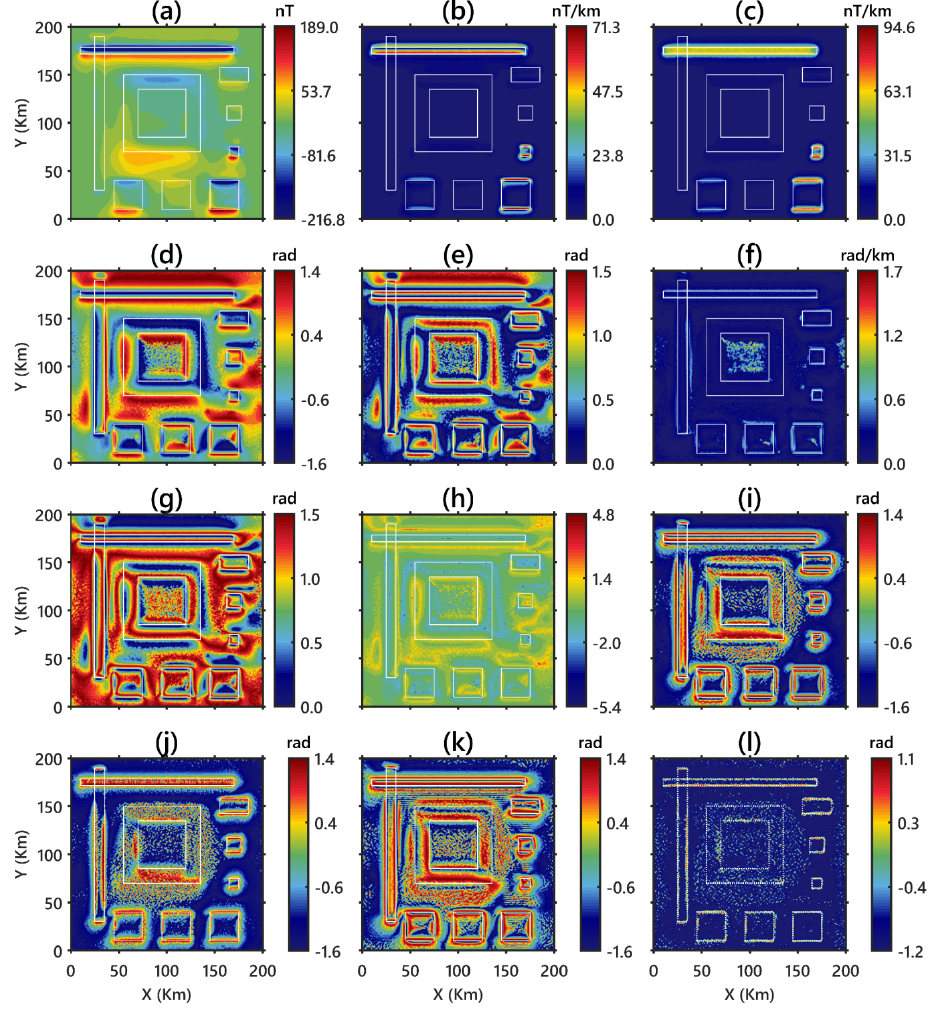
Figure 8. The results obtained after an upward continuation. ( a ) The magnetic anomaly continued 1000 m upward; ( b ) HG; ( c ) AS; ( d ) TA; ( e ) TM; ( f ) HGTA; ( g ) TDX; ( h ) HTA; ( i ) TAHG; ( j ) TAAS; ( k ) TBHG; and ( l ) ETG. The white lines show the true edge of the prisms.